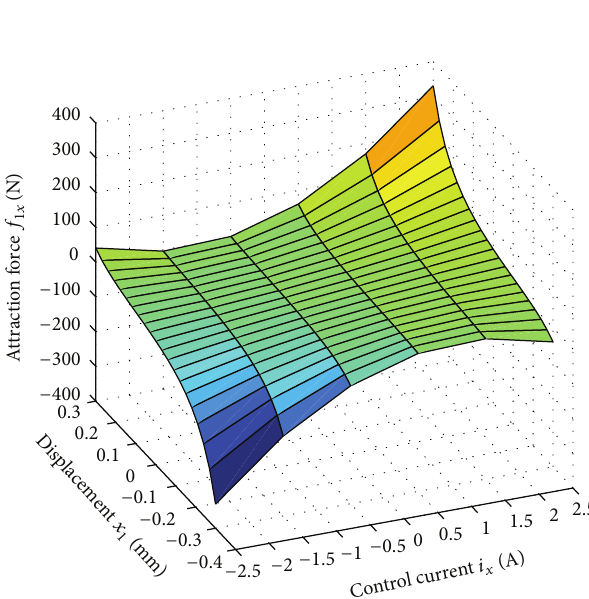
Figure 3: Characteristics of electromagnetic